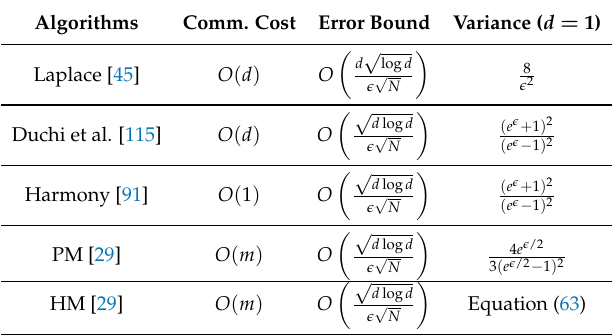
Table 9. Comparisons of mean estimation mechanisms on d -dimensional numeric data with